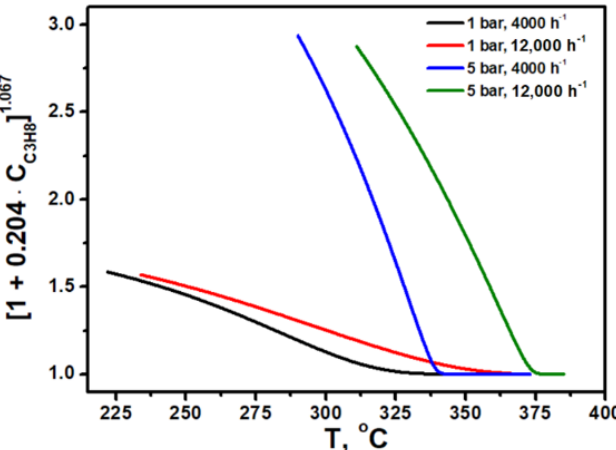
Figure 4. Temperature dependence of the denominator of the Langmuir–Hinshelwood model for the experiments on propane pre-reforming under 1 bar and 5 bar and at flow rates of 4000 and 12,000 h −1 .